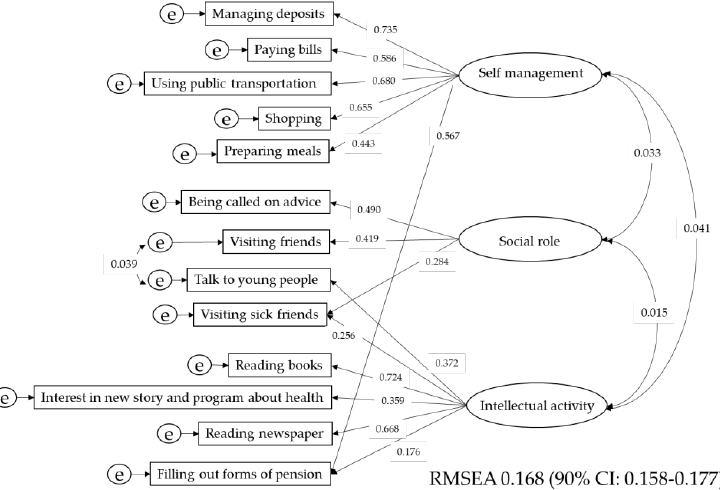
Figure 2. Structure of the ADL. Items of the TIMG Index involved 3 factors. Visiting sick friends and filling out the pension. Pension were correlated with two latent variables. Correlations between latent variables were statistically significant. However, the correlations were very weak. ADL: activity of daily living, TMIG index: The Tokyo Metropolitan Institute of Gerontology index of competence. e: Error variable. REMSEA: root-mean-square error of